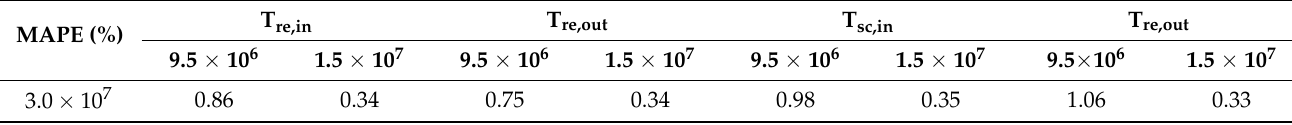
Table 4. MAPEs for grid independence under 1 s.